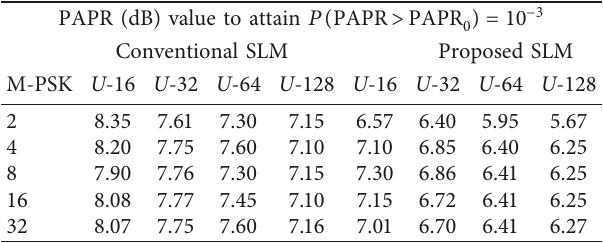
Figure 17: Comparison of SLM given in [5] with the proposed SLM for U � 16, 32, 64, and 128, N � 128, and 32-PSK. Table 4: CCDF performance investigation of conventional SLM and proposed SLM for N � 128 and U � 16, 32, 64, and